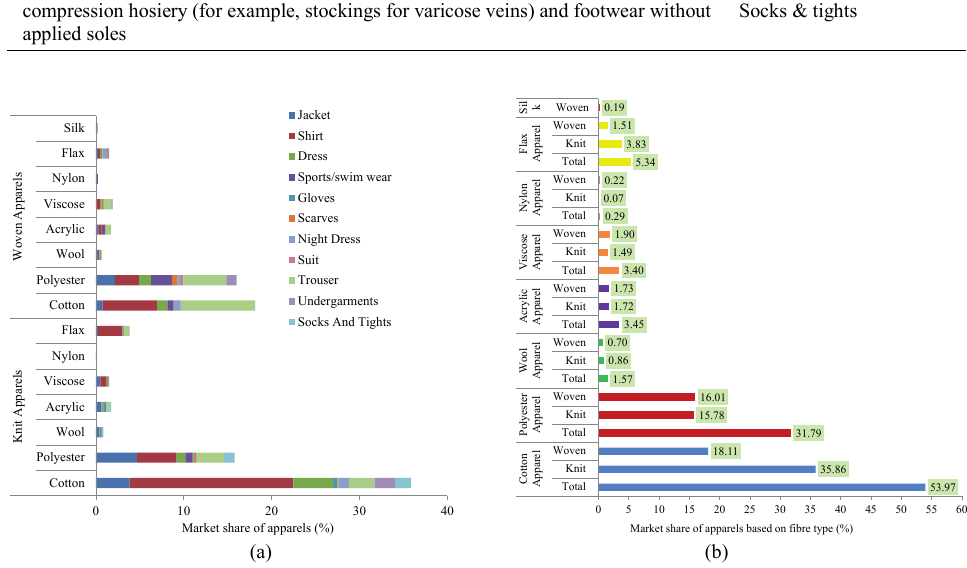
Fig. 4. Market volume of apparel in terms of apparel type (a) and fibre type